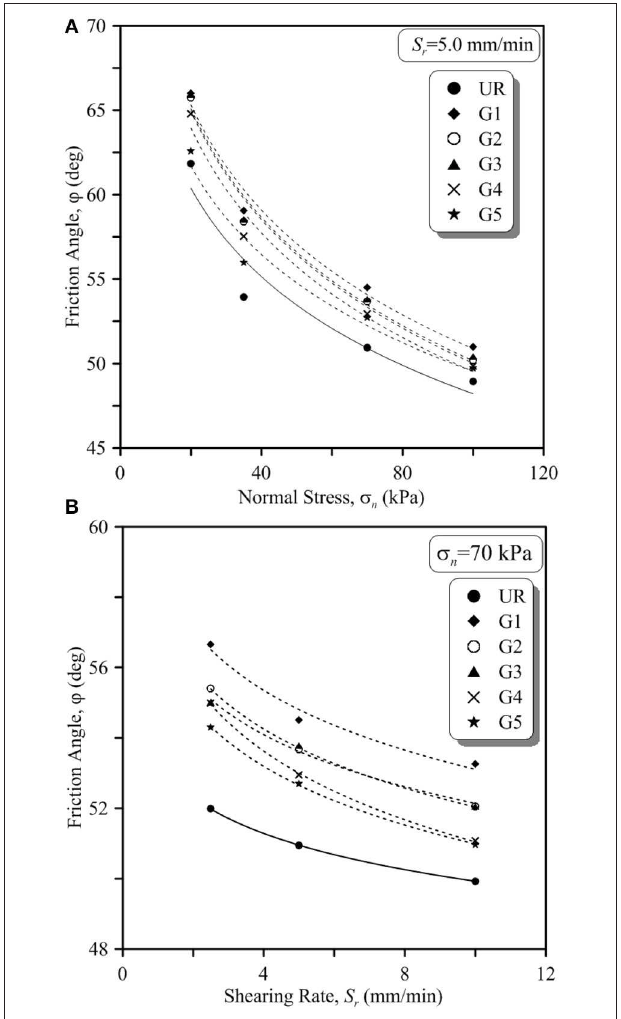
FIGURE 3 | Variation of friction angle of unreinforced and geogrid-reinforced ballast-sub-ballast with (A) applied normal stress at S r = 5.0 mm/min and (B) shearing rates at σ n = 70